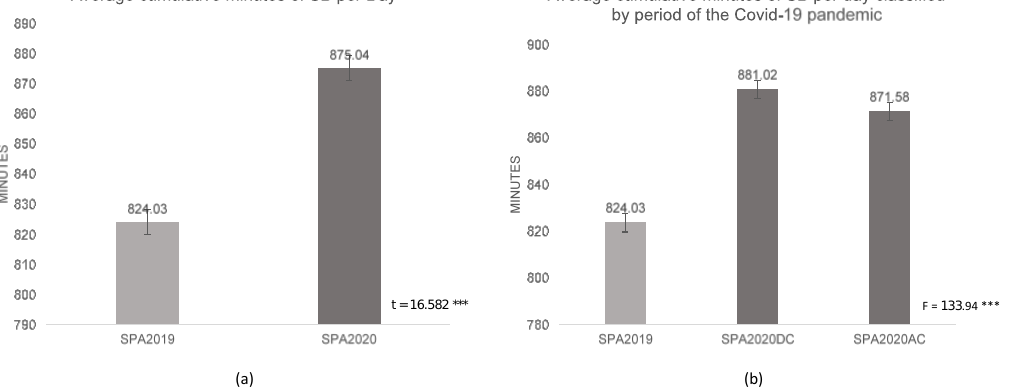
Figure 1. Average cumulative minutes of SB per day of the Thai population. ( a ) Average cumulative minutes of sedentary behavior (SB), ( b ) Average cumulative minutes of SB classified by the period of the Covid-19 pandemic: BC-DC-AC. BC (before curfew) March–May 2019, DC (during maximum curfew) 29 March to 2 May, and AC (after maximum curfew was relaxed). ***: significant at p -value 0.000. SPA: Surveillance on Physical Activity. SB: Sedentary